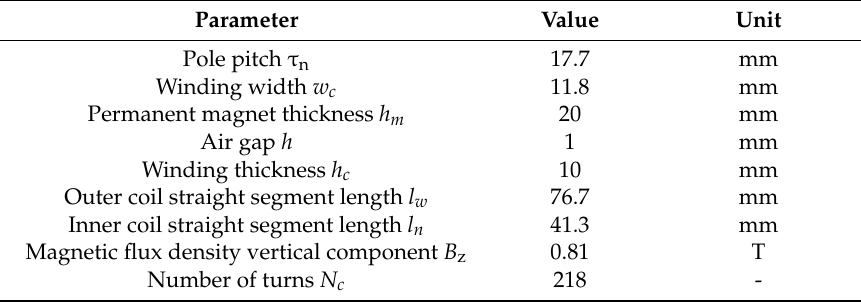
Table 1. Electromagnetic model